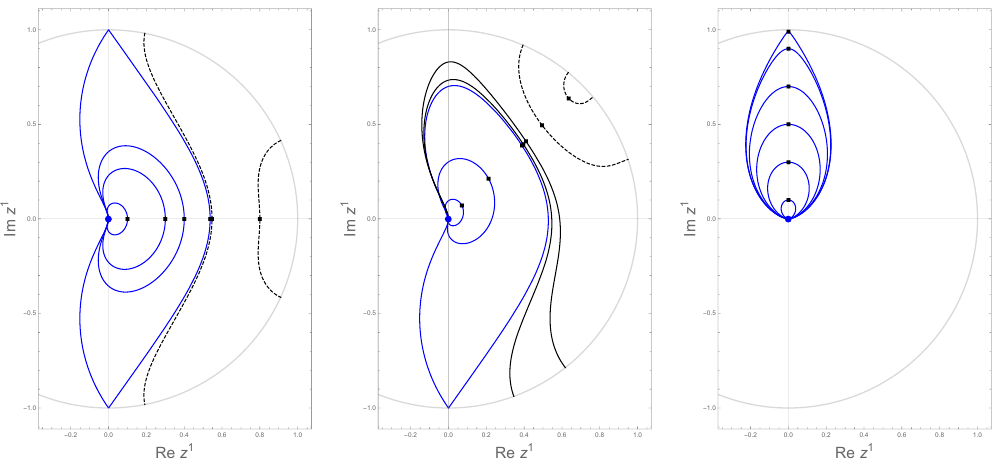
Figure 1. The family of BPS solutions for the N = 2 ∗ model is summarised by parametrically plotting the real and imaginary parts of the scalar field z 1 . The black squares correspond to turning points of the function A J ( r ) and the three plots, from left to right, correspond to solutions where the phase of the complex scalar field at the turning point is 0 , π/ 4 and π/ 2 , respectively. The blue dot at the origin is the N = 4 SYM AdS 5 vacuum solution and the blue lines are Janus solutions. The boundary of field space is | z 1 | = 1 , marked with the grey circle. As one moves from r = −∞ to r = + ∞ one moves clockwise on the